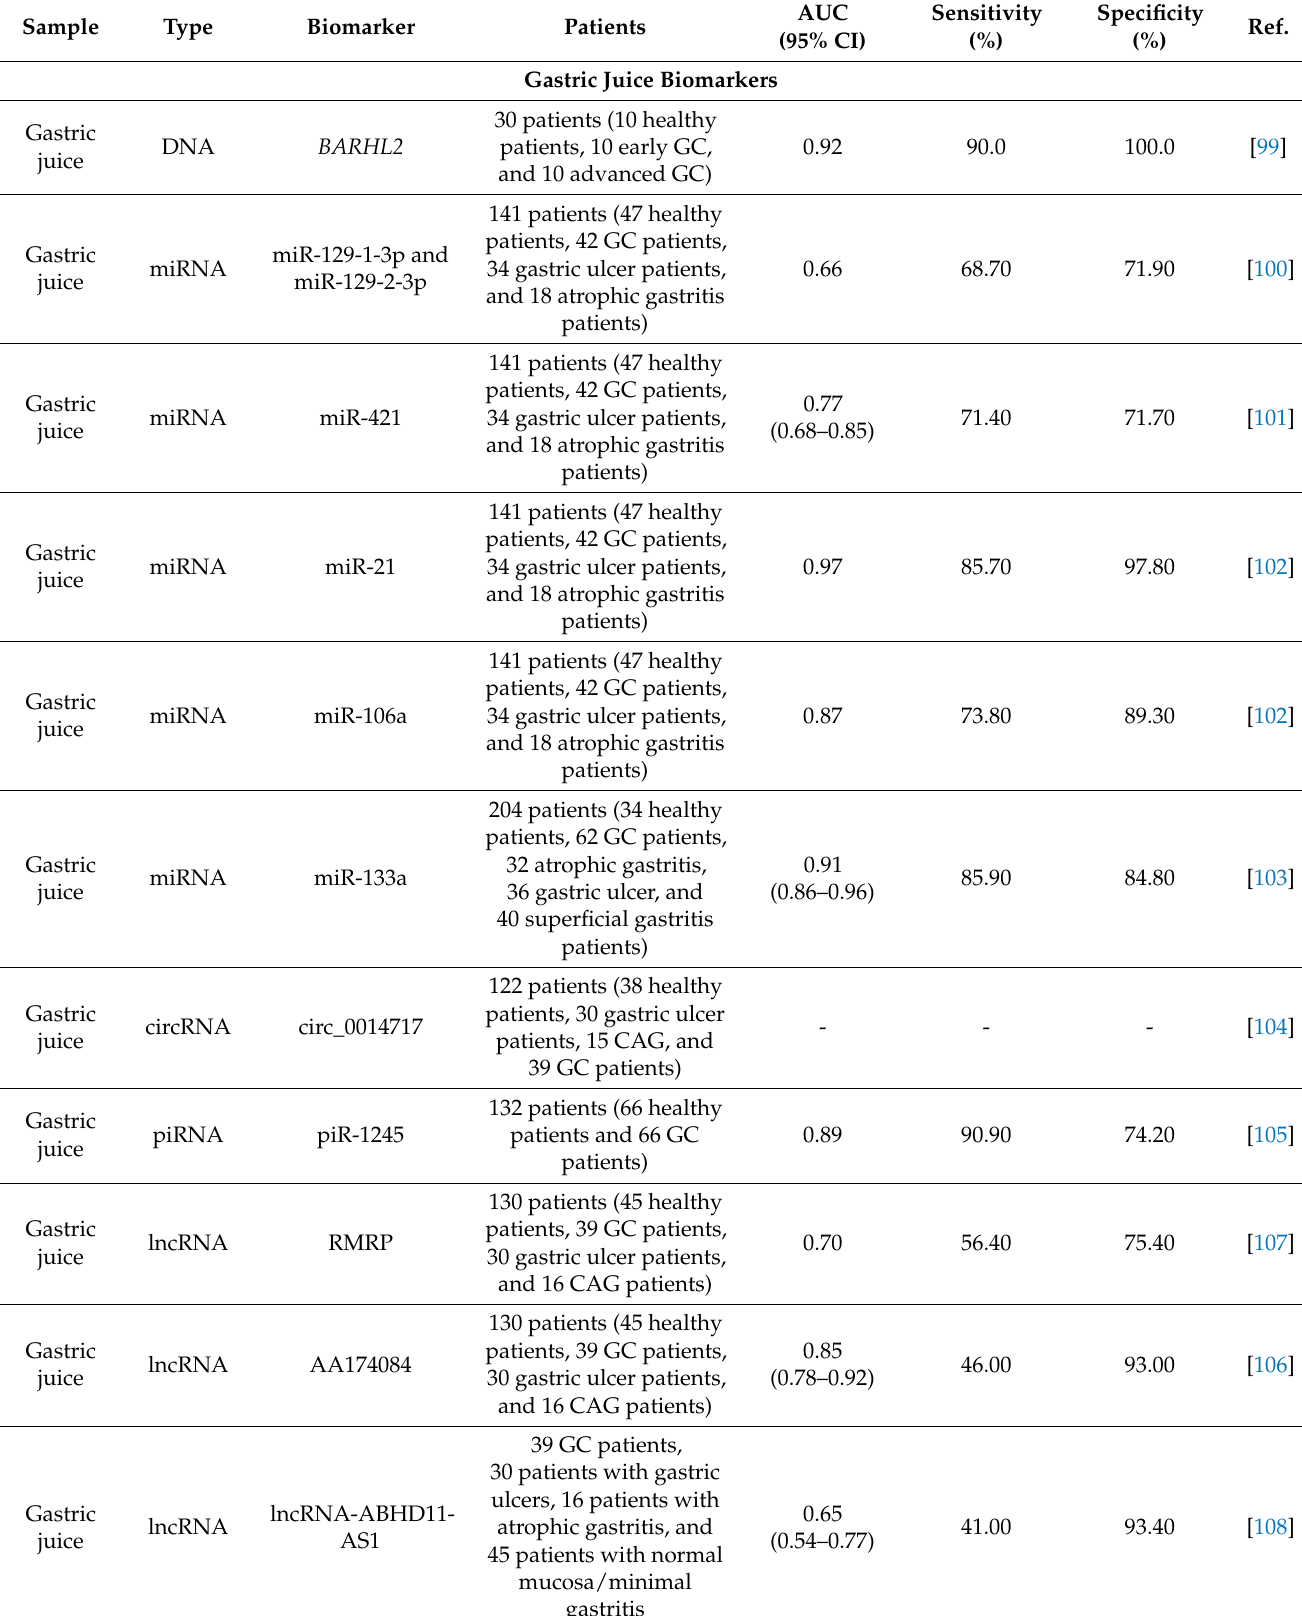
Table 5. Summary of potential biomarkers in gastric juice for gastric cancer screening and early diagnosis.